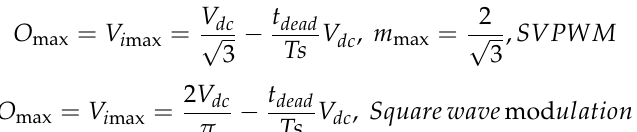
Figure 13. Block diagram of proposed PR controller with anti-wind-up capability.